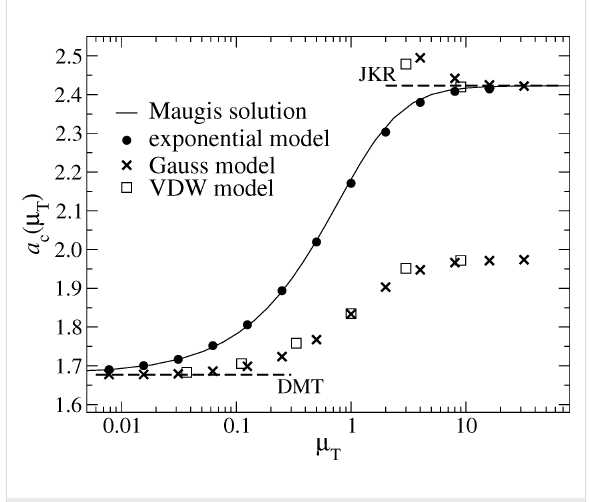
Figure 9: Contact radius a c at zero external load as a function of the Tabor coefficient μ T for different model interactions: exponential (full circles), Maugis Dugdale (straight lines), Gauss (crosses), and VDW (open squares). The upper and lower broken line denote the DMT and the JKR limits, respectively. In the Gauss and VDW models, two different definitions are used for a c : The upper symbols refer to the position where g ′ ( r ) reaches a local maximum, while the lower symbols indicate the points of first gap closure ( g = 0).